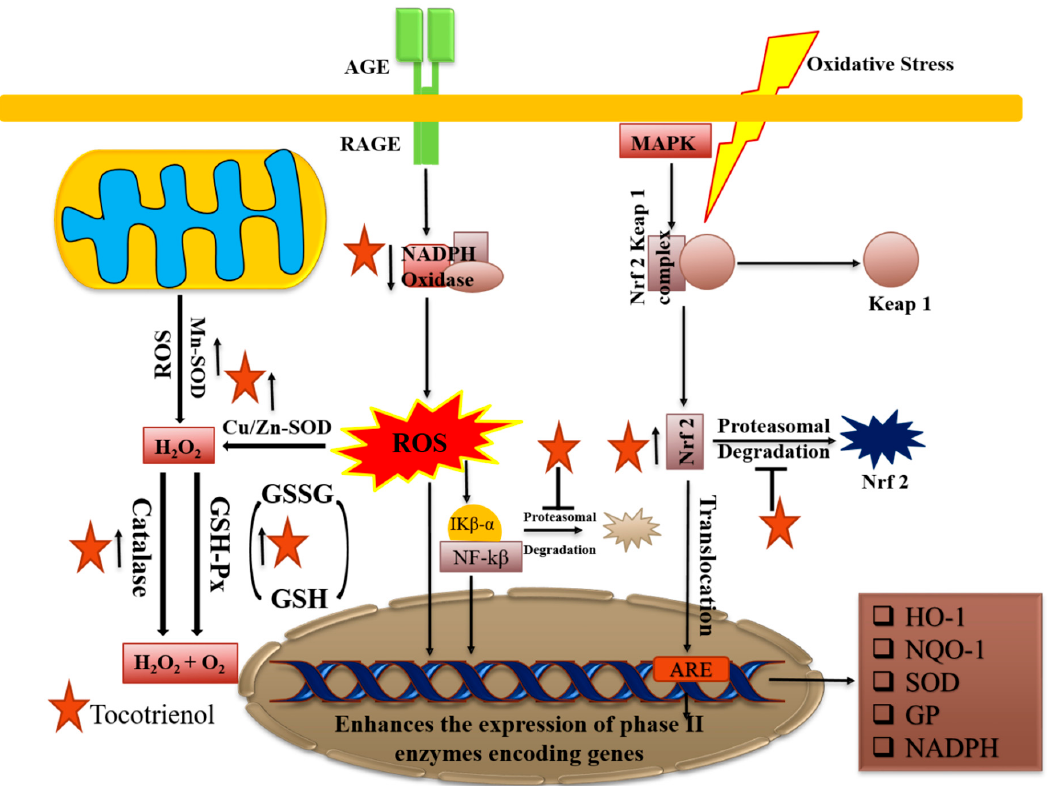
Figure 5. Tocotrienols can act against oxidative stress and increase the expression of anti-oxidant enzymes such as GSH (glutathione)-synthase, catalase, and SOD (superoxide dismutase). They can block the NADPH ((nicotinamide adenine dinucleotide phosphate) oxidase complex and their downstream target inflammatory genes and increase the nuclear translocation of Nrf-2 (nuclear factor erythroid 2–related factor 2).